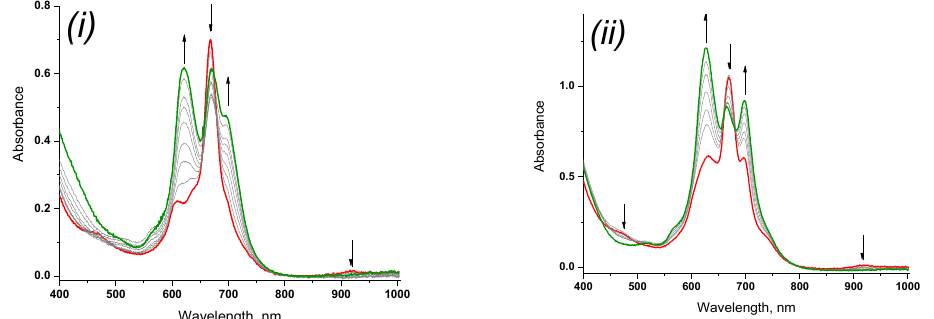
Figure 8. Changes in the UV-vis for 5 ( i ) at (c = 2.1 × 10 − 5 mol/L) and 3 ( ii ) (c = 1.2 × 10 − 5 mol/L) in a THF solution in the presence of phenylhydrazine 3 × 10 − 4 mol/L) min (red curve—the initial spectrum, green—the final one). Table 2. Observed constants and rate constants of the redox process for solutions of macrocycles